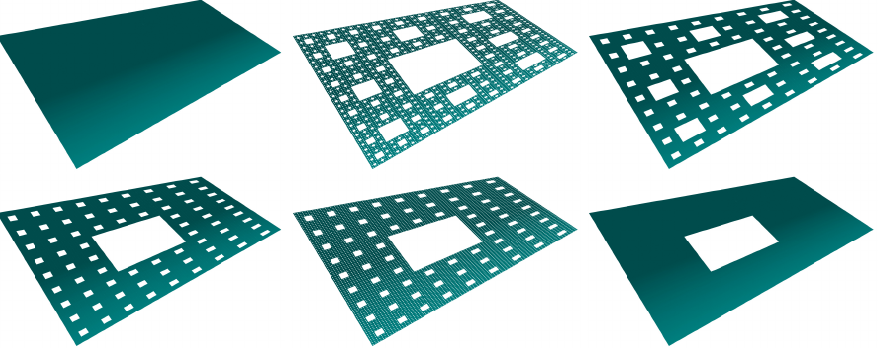
Figure 5. Attractors generated by the multiple-function system F 2 (cid:101) with (cid:101) = ( 0,0,0,0 ) , (1,1,1,1), (0,1,1,1), (0,1,0,1), (1,0,1,0), (0,0,0,1) (from left to right and top to